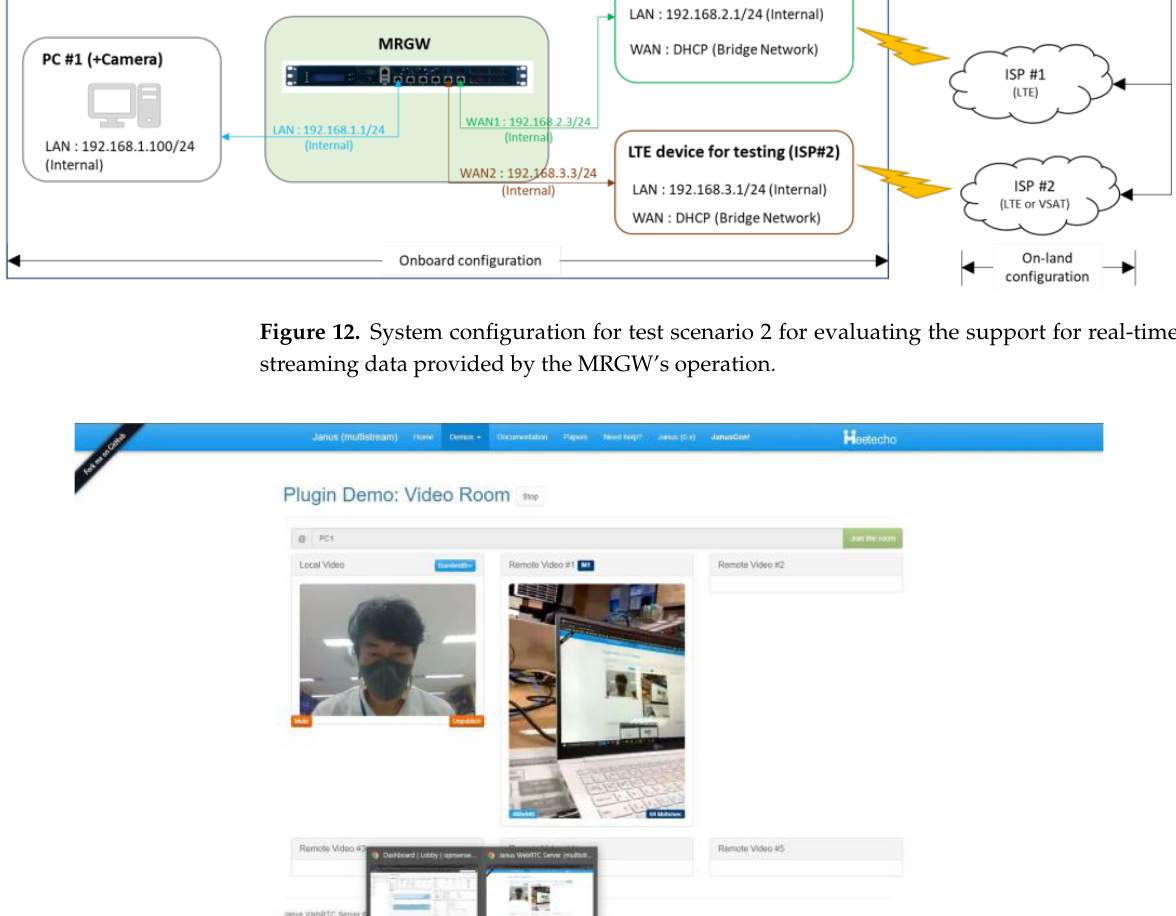
Figure 13. Experiment outcome of test scenario 2 (Chrome browser screenshot of the video room through Web-RTC server (Janus)).